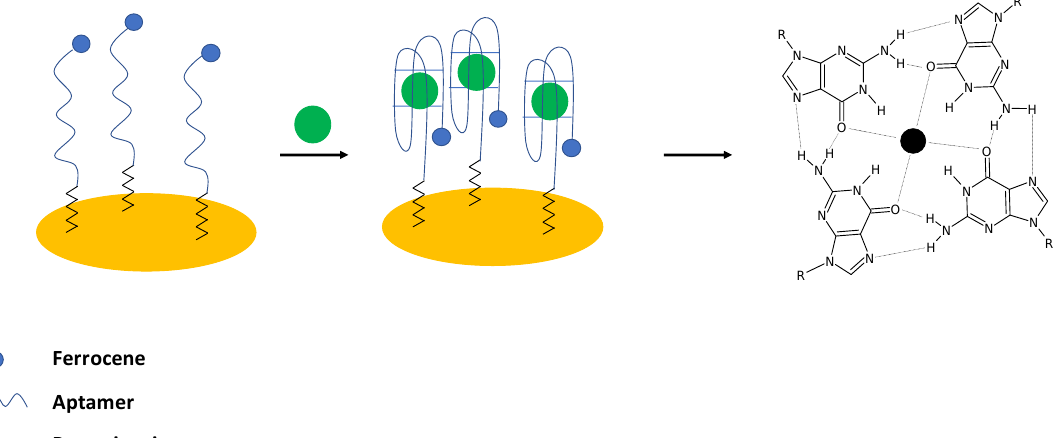
Figure 1. The sensing principle scheme of the electrochemical aptasensor with ferrocene labeled DNA as a receptor probe.